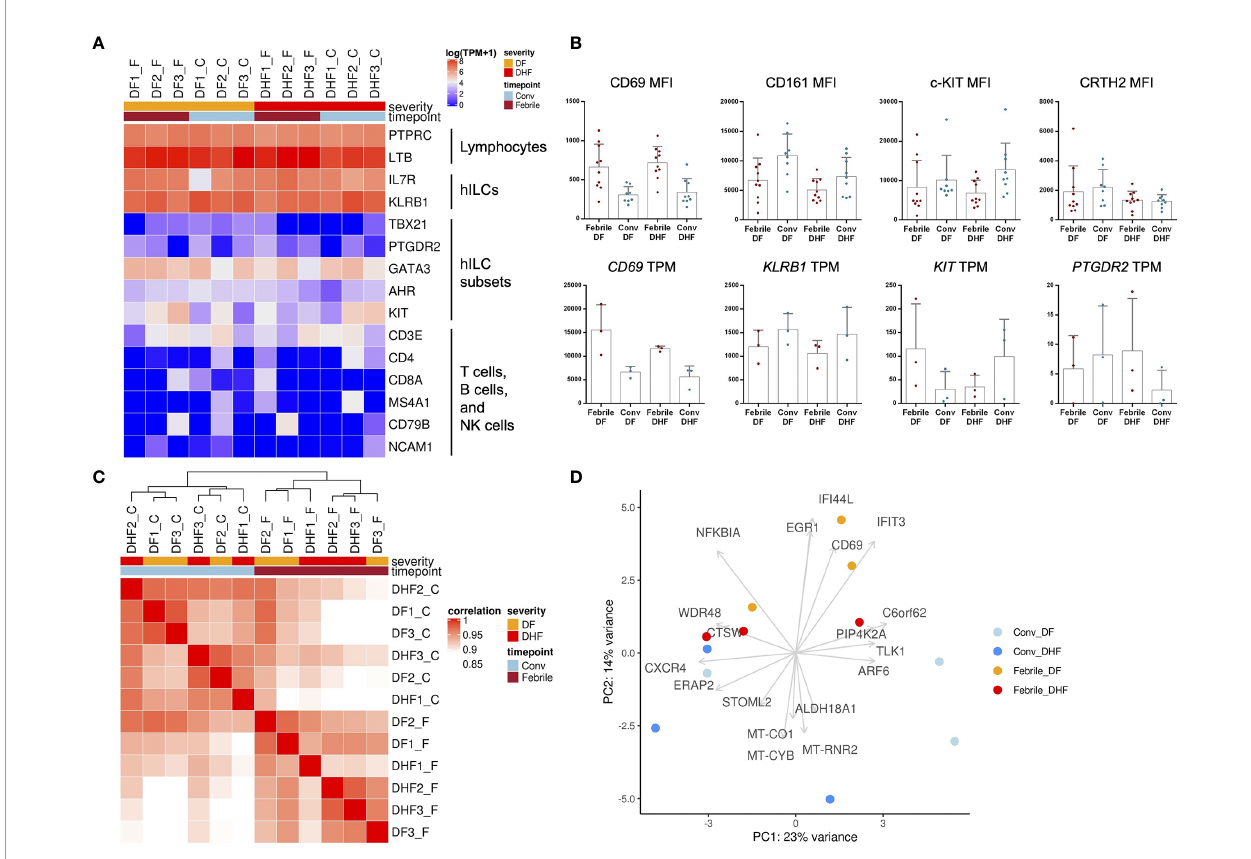
FIGURE 4 | Transcriptome analysis of hILCs from DENV-infected patients. (A) Heatmap showing expression level (in TPM) of known hILCs and their subsets ’ signature genes as compared to those of T cells, B cells and NK cells in each sample arranged according to disease severity (DF, DHF) and timepoints (febrile, convalescence). (B) Bar plots show mean MFI from previous fl ow cytometry experiment (upper panel) and gene expression levels in TPM (lower panel) for CD69, CD161 ( KLRB1 ), c-kit (CD117, KIT ), and CRTH2 (CD294, PTGDR2 ). (C) Correlation of global transcriptome pro fi les of hILCs in all samples. Unbiased hierarchical clustering shows high correlation amongst samples according to timepoints (febrile phase clustered together and away from convalescence). (D) PCA plot with top contribution genes for PC1 and PC2 shows separation between febrile and convalescent phase on PC2 which were contributed by the expression of CD69 , EGR1 , IFIT3 , NFKBIA , and IFI44L . Sample number indicated on top of heatmap; DF1_F (DF sample number 1, febrile phase), DF1_C (DF, sample number 1, convalescent